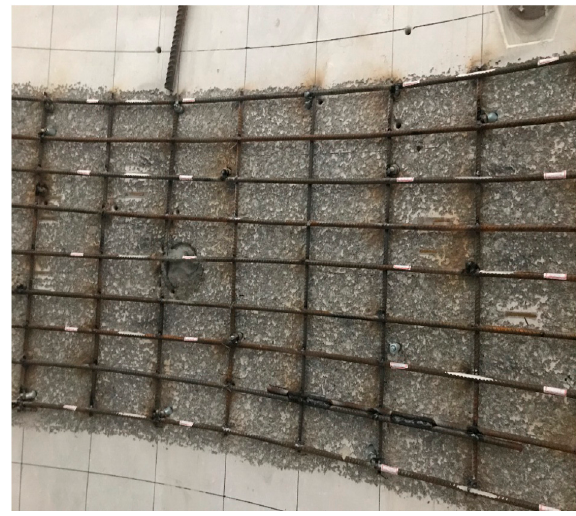
Figure 5. Layout of reinforcement cages.